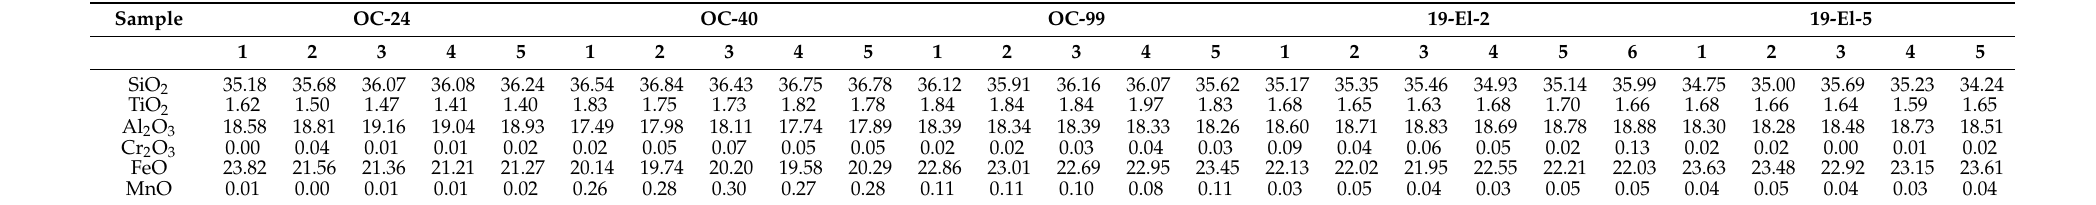
Table 2. Composition of biotite and Ti-in-Bt